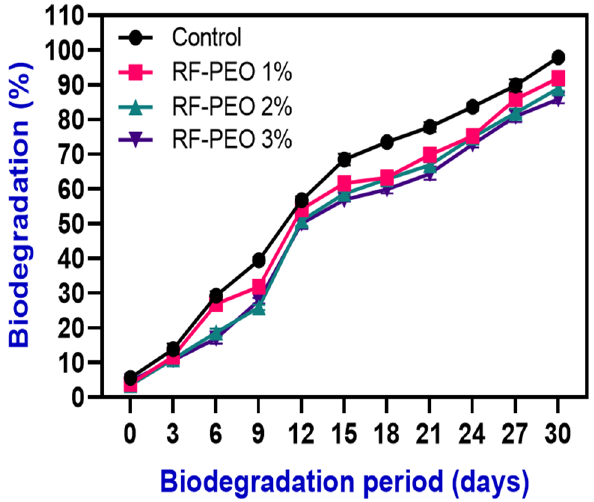
Figure 8. Biodegradability examination of edible fi lms composed of RF–PEO at varying concentra-